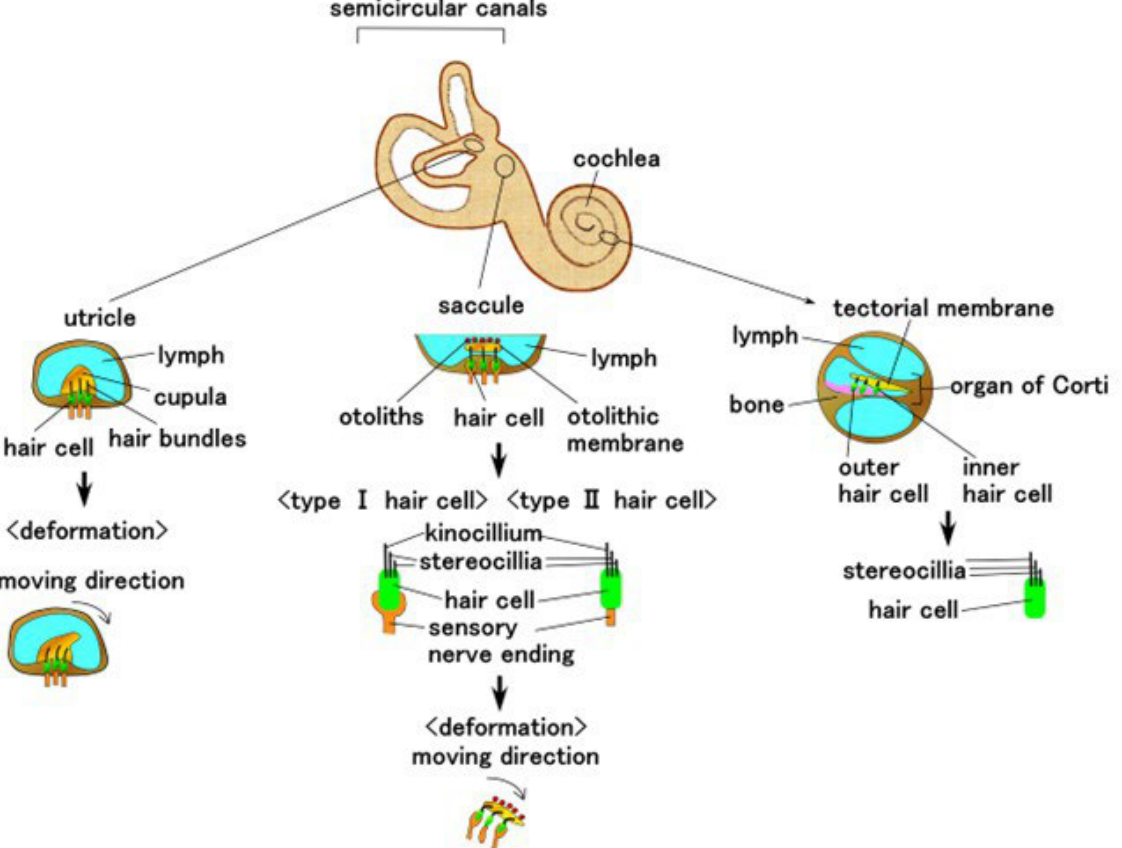
Figure 1. Schematic anatomical diagram showing the general structure and position of semicircular canals and cochlea in the human ear.